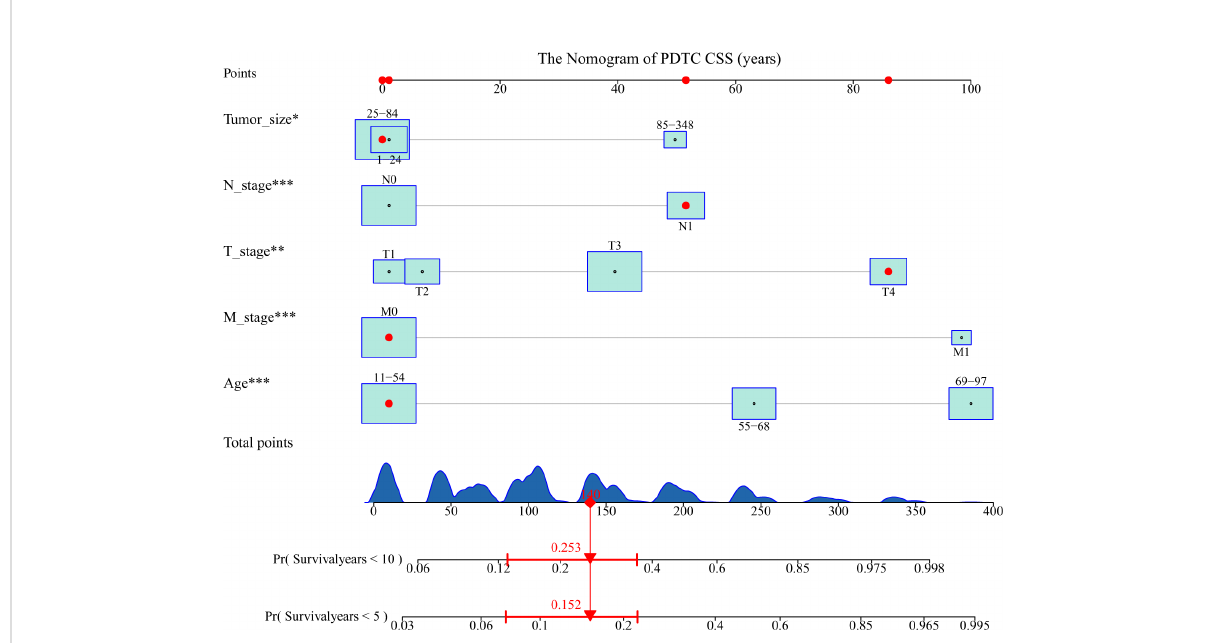
FIGURE 3 Nomogram predicting the 5- and 10-year cancer-speci fi c survival (CSS) of patients with poorly differentiated thyroid carcinoma (PDTC) using fi ve factors (i.e., age, T, N, M, and tumor size). The fi gure assumes a PDTC patient with a tumor size between 1-24 mm, lymphoid metastases, stage T4, no distant metastases, and an age between 11-54. His 5- and 10-year cancer-speci fi c mortality rates are predicted to be 15.2% and 25.3%. * means <0.05,** means <0.01,*** means